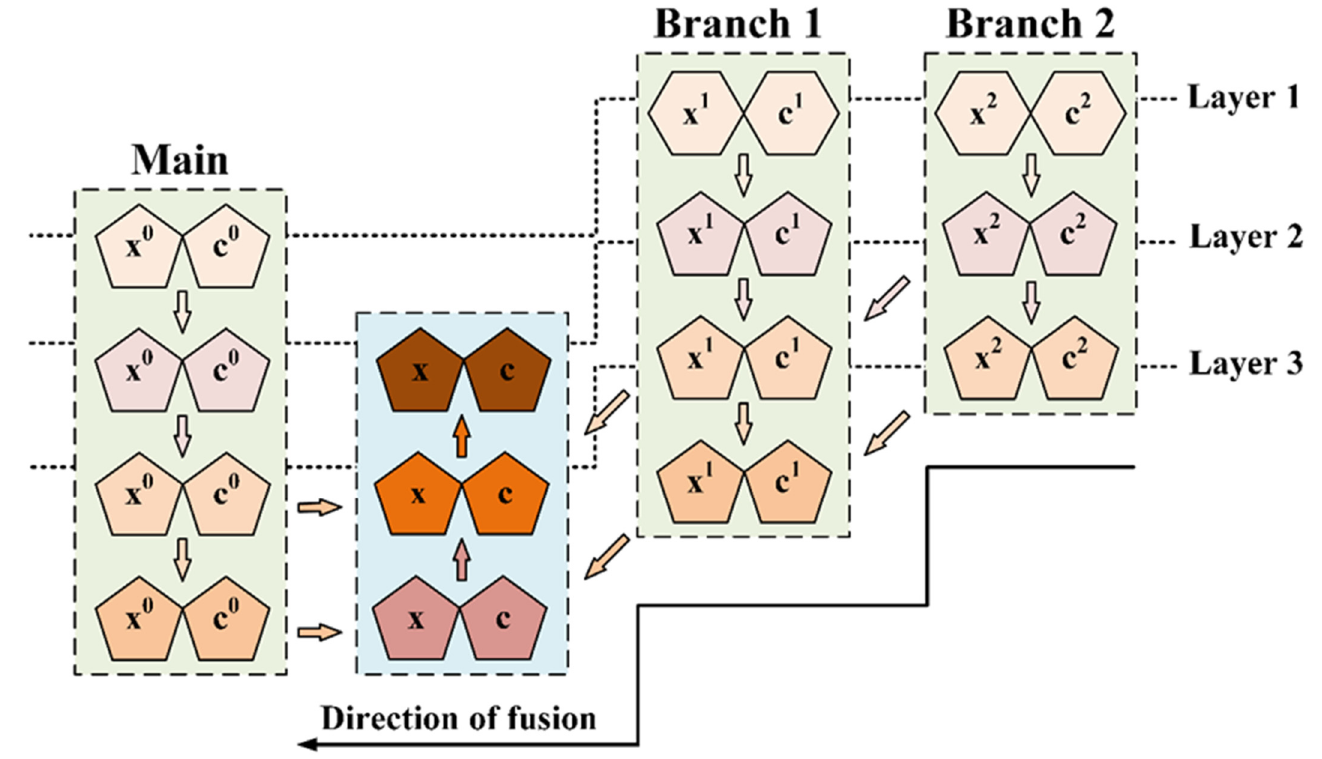
Figure 3. The schematic diagram of the dense progressive fusion module. There is a main road and two branches with different resolutions. The down arrows in the dashed box represent the down-sampling, and the up arrows are the up-sampling. After the fusion of multiple branches, the color of the feature is gradually deepened, which means that the effect is gradually better.